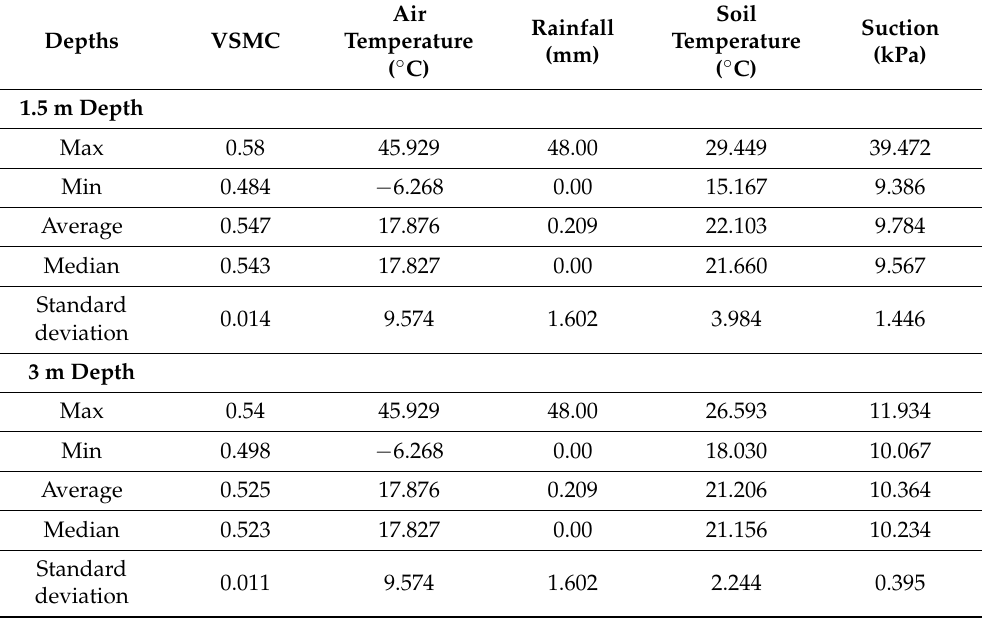
Table A5. Preliminary Detailed Statistics for the constructed dataset HWS